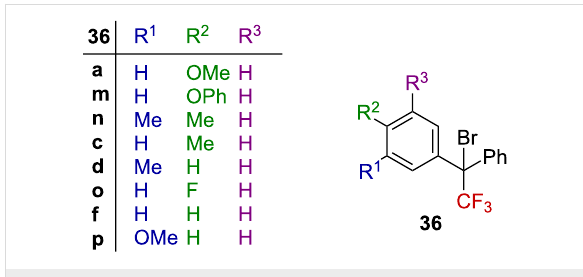
Figure 7: Structure of bisarylated derivatives 36 .